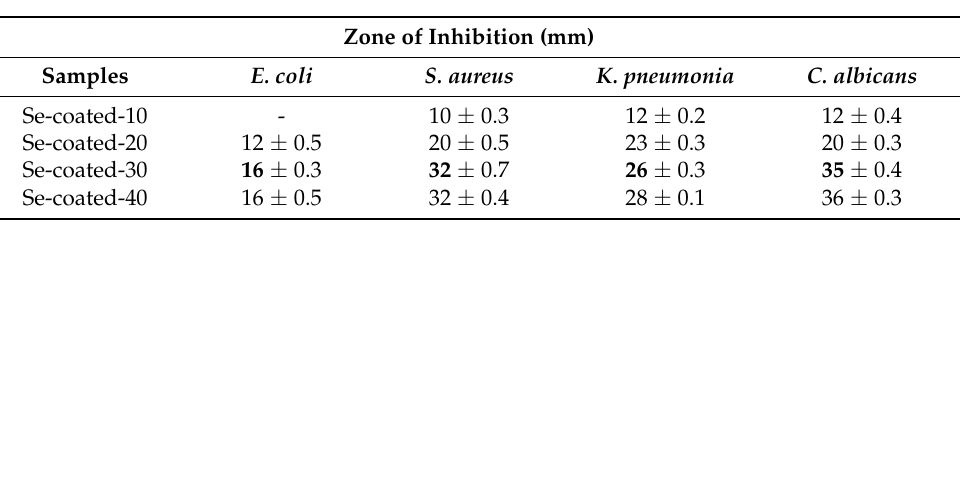
Table 1. Shows ZOI (mm) around Se-coated samples against different microbial strains on agar plate. Data are represented as mean with standard deviation ( n =